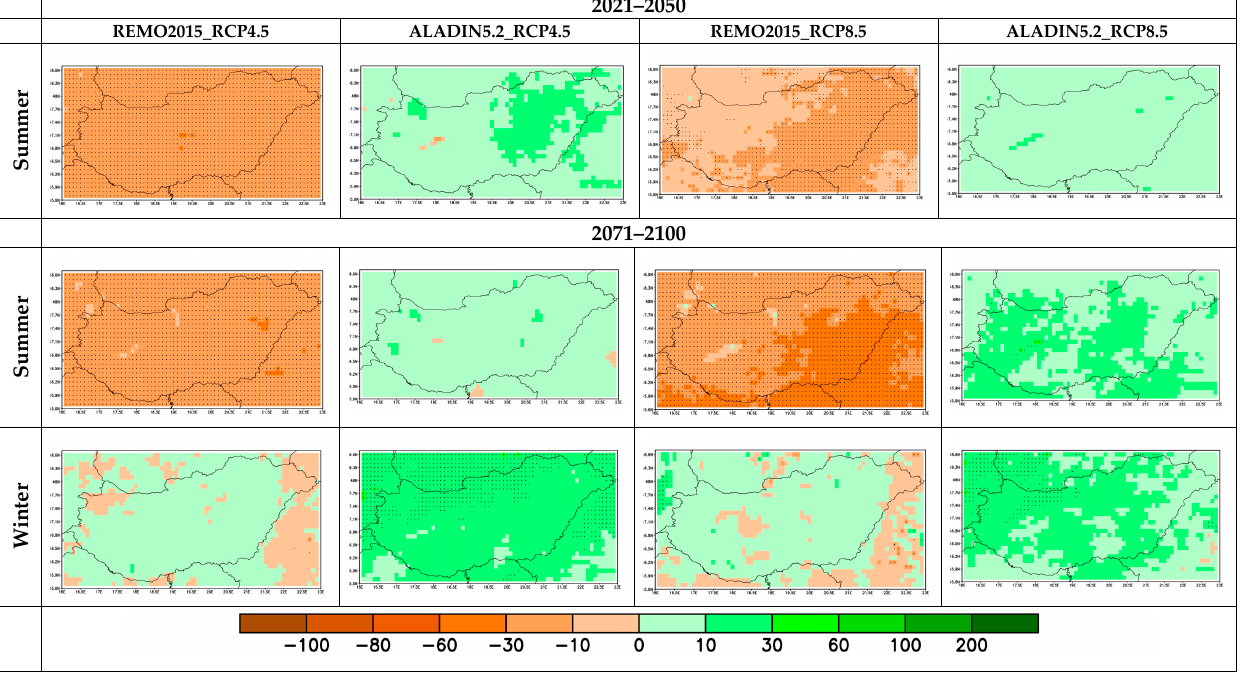
Figure 20. Relative change in the number of wet days (%) in summer for 2021–2050 and 2071–2100, and in winter for 2071–2100 in Hungary based on the ALADIN5.2 and REMO2015 simulations. Reference period: 1971–2000.